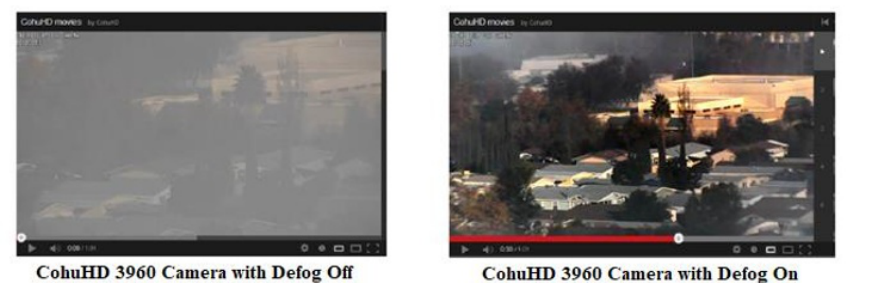
Fig. 6. Image processing by CohuHD 3960HD Camera.